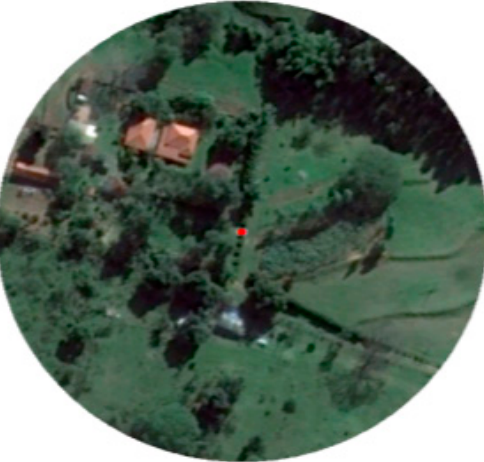
Figure 2. Characteristics of the rural surroundings of Presidente Prudente where the temperature sensor was installed (red point).